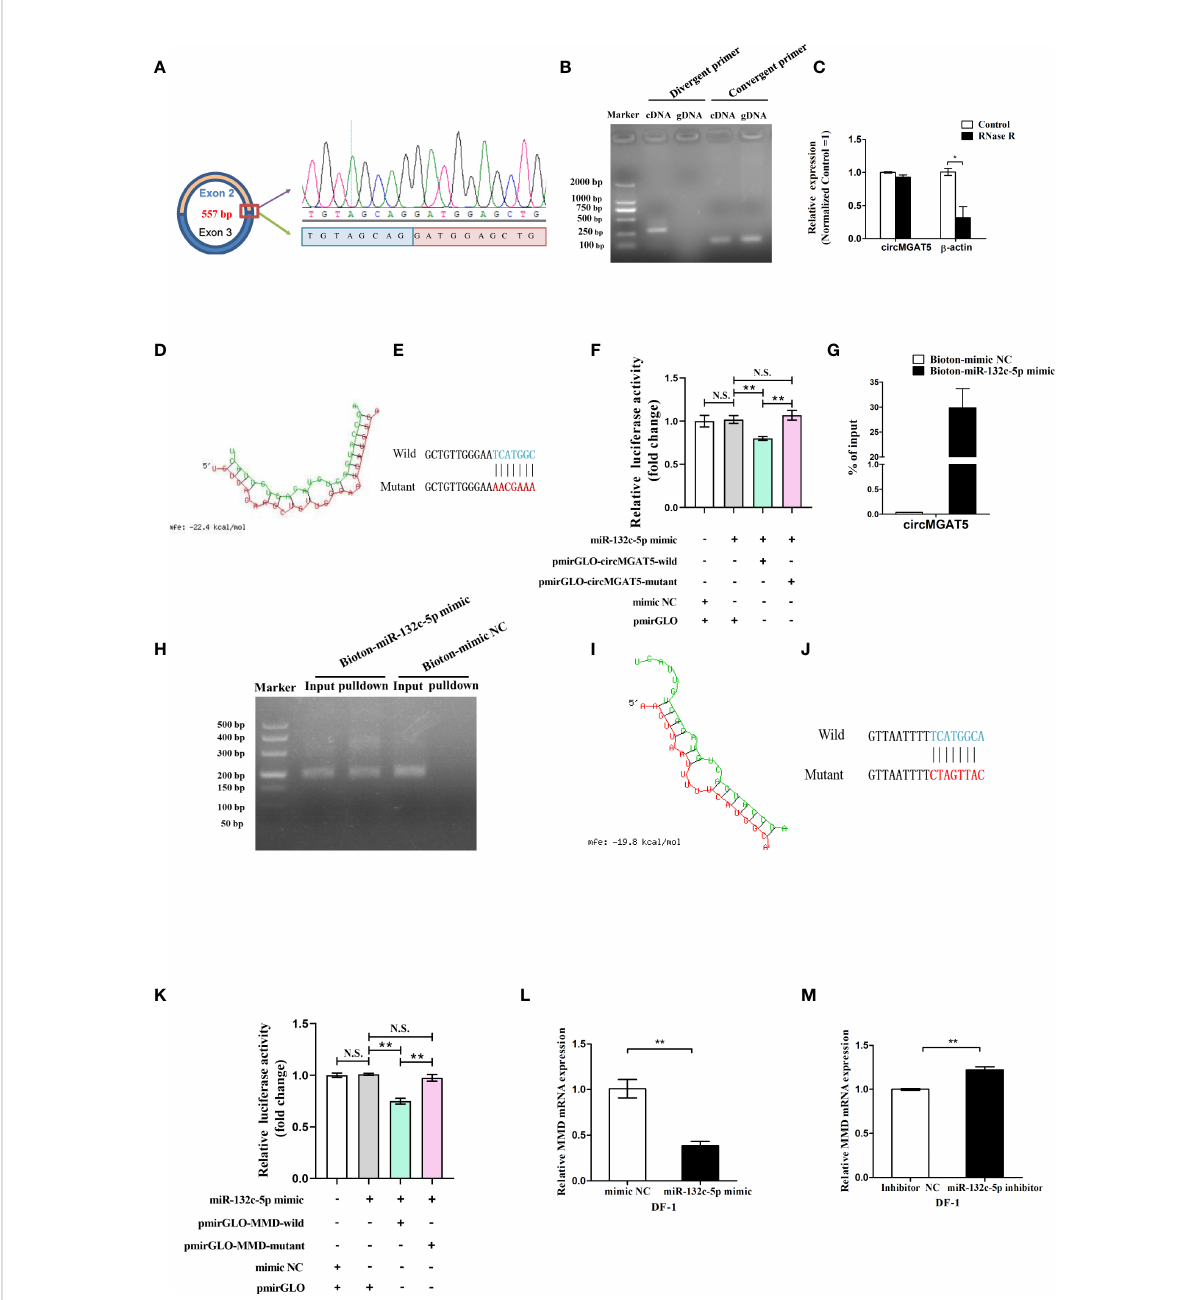
FIGURE 5 Identi fi cation of circMGAT5 - miR-132c-5p - MMD axis. (A) Ampli fi cation of the junction sequence of circMGAT5 . (B) Divergent primers amplify circMGAT5 in cDNA but not genomic DNA (gDNA). (C) RT-qPCR quanti fi cation of circMGAT5 after RNase R treatment. (D) The potential interaction model between circMGAT5 and miR-132c-5p predicted by RNAhybird. (E) The wild and mutant binding site sequence between circMGAT5 and miR-132c-5p in the pmirGLO vector. (F) Dual-luciferase reporter assay measuring the binding of circMGAT5 to miR-132c-5p . (G) RT-qPCR quanti fi cation of circMGAT5 enriched in the biotinylated miR-132c-5p mimic pull down RNA. (H) qPCR product of circMGAT5 in the biotinylated miR-132c-5p mimic pull down RNA and biotinylated mimic NC. (I-M) miR-132c-5p interacts with MMD . (I) The potential interaction model between miR-132c-5p and MMD predicted by RNAhybird; (J) The wild and mutant binding site sequence between miR-132c- 5p and MMD in the pmirGLO vector; (K) Dual-luciferase reporter assay measuring the binding of miR-132c-5p to MMD ; (L) miR-132c-5p mimic inhibits the expression of MMD ; (M) miR-132c-5p inhibitor promotes the expression of MMD . For (C, F, G, K, L, M) , results are shown as mean±SEM. Statistical signi fi cance of differences between means was assessed using unpaired Student ’ s t-test. (* P <0.05; ** P <0.01; N.S. no signi fi cant